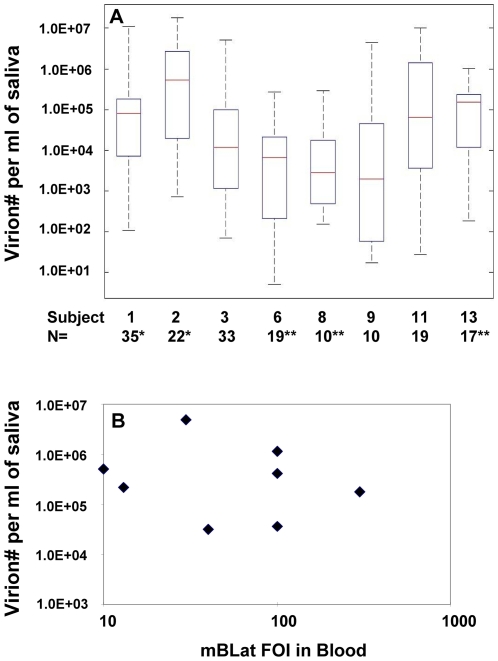
There is no such entity as a consistently high or low shedder of EBV and no correlation between the levels of shedding and the frequency of infected mBLat in the blood.(A) Shows the range of virus shedding in 8 individuals over months/years. Note that shedding varies between 3.5 and 5.5 logs. Red bars = the median, black box = 25th and 75th percentile, dashed line = the range, N = the number of independent positive measurements. * - the number of asterisks indicates the number of time points when no virus shedding was detected. (B) Shows the mean values for the data shown in A. plotted versus the frequency of infected mBLat (FOI) in the peripheral blood for each subject.